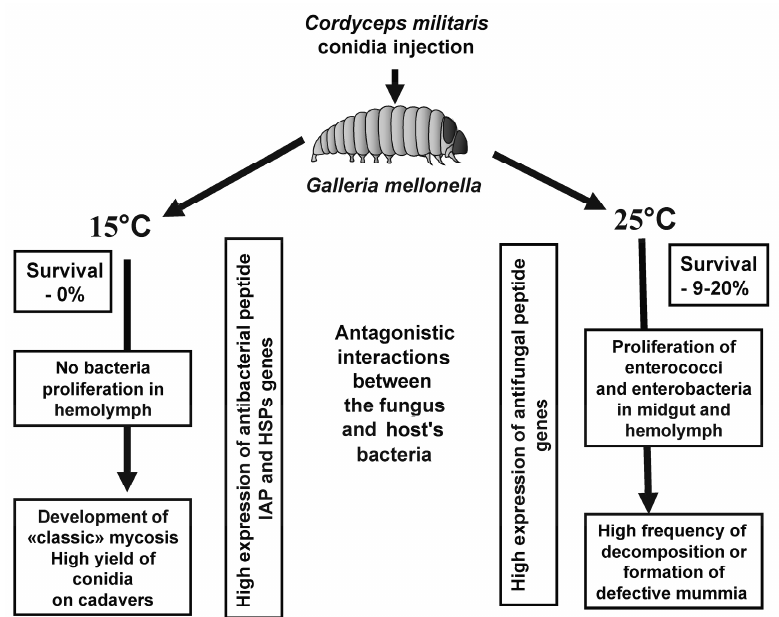
Figure 8. Outline of the interactions between C. militaris and bacterial associates in wax moth larvae under di ff erent temperature conditions.